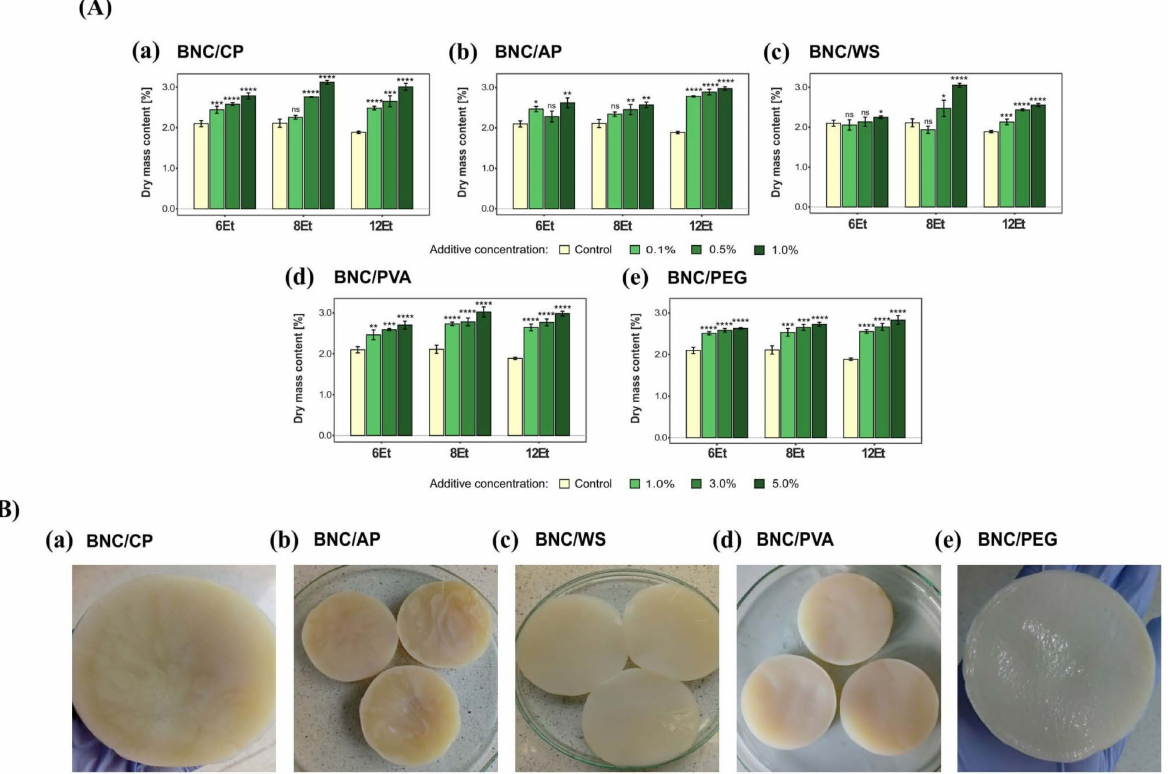
Figure 8. ( A ) Dry mass content in bacterial cellulose composites produced by K. hansenii H3 (6Et), K. rhaeticus K4 (8Et), and the strain isolated from balsamic vinegar (12Et). ( a ) BNC/CP, ( b ) BNC/AP, ( c ) BNC/WS, ( d ) BNC/PVA, and ( e ) BNC/PEG. Statistically significant differences were calcu- lated using a one-way ANOVA with Tukey’s multiple comparison post-hoc test and are shown as * = p ≤ 0.05, ** = p ≤ 0.01, *** = p ≤ 0.001 and **** = p ≤ 0.0001, as compared to control (native) membranes. ( B ) Composites synthesized by the 6th strain: ( a ) BNC/CP and ( b ) BNC/AP with visible heterogenous streaks formed by pectins, ( c ) more loose, gelatinous BNC/WS films, ( d ) BNC/PVA and ( e ) BNC/PEG with compact, homogeneous structure and visible layer of added